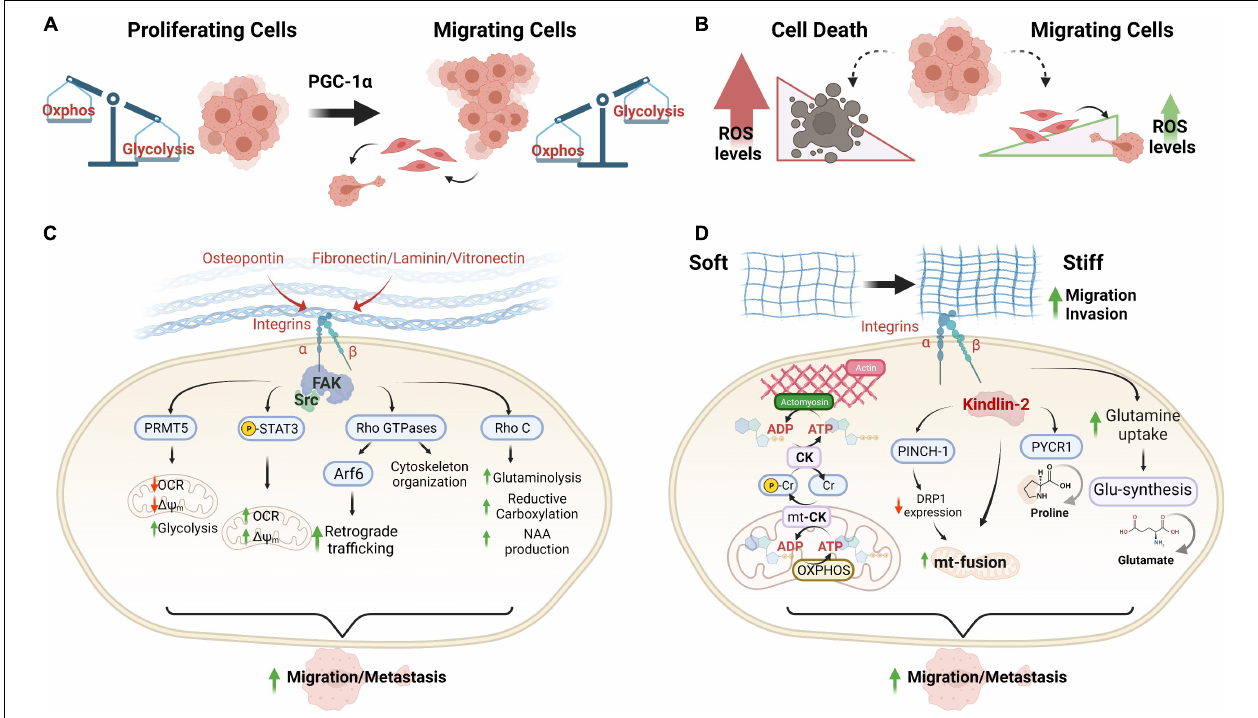
FIGURE 1 | Extracellular matrix signals induce metabolic plasticity for increasing the mitochondrial bioenergetics of cancer cells during the metastastic cascade. (A,B) Differential metabolic phenotypes between proliferating and migrating cancer cells. PGC-1 α has been recognized as an essential regulator of the metabolic shifts that support metastasis. (C) Mitochondrial adaptations driven by ECM components and mediated by integrin and FAK signaling in cancer cells. (D) Adaptations of mitochondrial bioenergetics driven by ECM stiffness in migrating cancer cells. Abbreviations: OXPHOS, oxidative phosphorylation; OCR, oxygen consumption rate; (cid:49) ψ m, mitochondrial membrane potential; pCr, phosphocreatine; CK, creatine kinase; mt-CK, mitochondrial creatine kinase; and NAA,